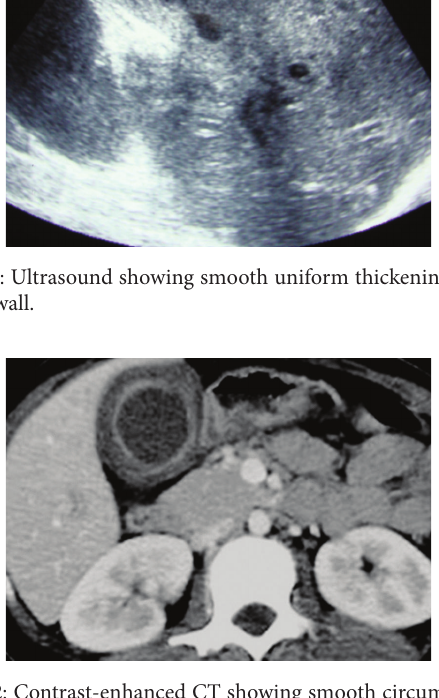
Figure 2: Contrast-enhanced CT showing smooth circumferential gallbladder wall thickening with a continuous contrast—enhanced mucosal line.